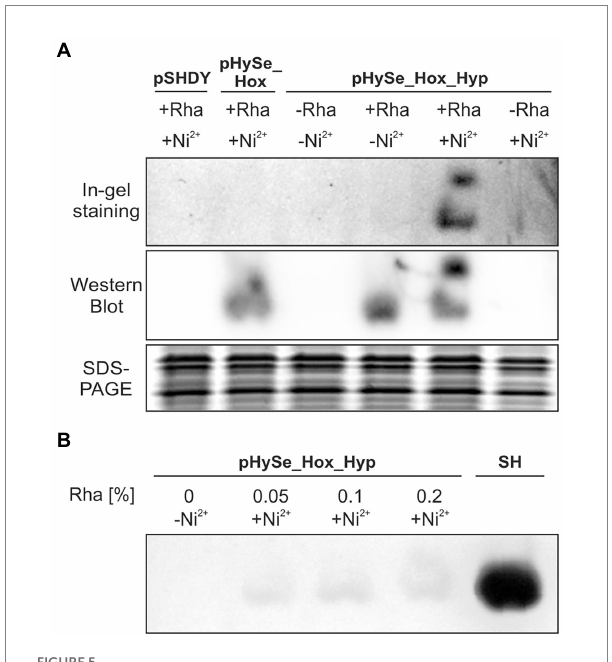
FIGURE 5 RH-mediated H 2 oxidation in Synechocystis . (A) Recombinant Synechocystis ( Δ hox ) strains lacking the endogenous hydrogenase and containing either pSHDY, pHySe_Hox, or pHySe_Hox_Hyp were grown photoautotrophically under aerobic conditions in the presence of the inducers, i.e., 0.1% (w/v) L-rhamnose (Rha) and/or 2.5 μ M Ni 2+ (indicated by +/ − ). Soluble proteins were separated via native PAGE and subjected to in-gel H 2 -dependent formazan staining to localize the H 2 -sensing complex (upper panel), as well as immunological detection of the HoxB-FLAG and HoxJ*-FLAG proteins (middle panel). A denaturing SDS-PAGE was conducted as loading control (lower panel). (B) In-gel activity of cells incubated with the given inducers using different amounts of Rha in % (w/v). A Synechocystis strain recombinantly producing the highly active NAD + -reducing soluble hydrogenase from C. necator (SH) served as positive